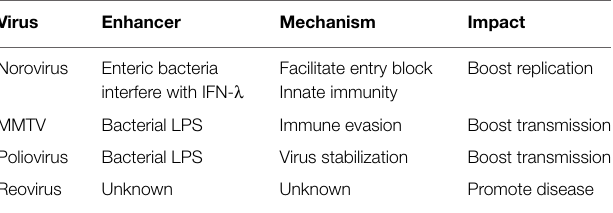
TABLE 1 | Pathogenic viruses that exploit intestinal bacteria .